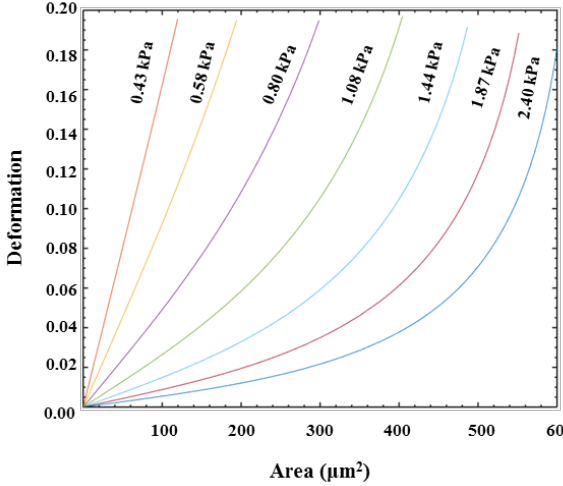
Figure 3. Iso-elasticity lines for elastic moduli as a function of deformation and cell size.